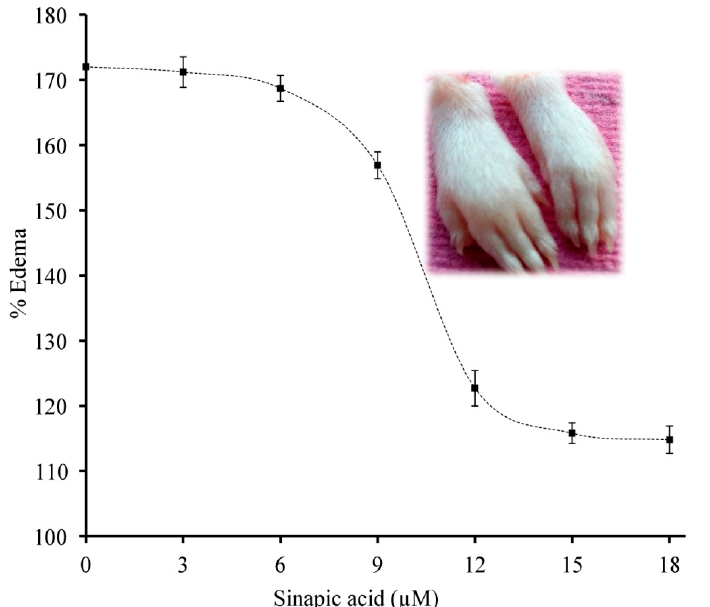
Figure 10. Neutralization of sPLA2-IIA induced edema: The preincubatedsPLA 2 -IIA enzyme (5 µg) with the indicated concentrations of sinapic acid injected to the right hind footpad of mice (20 µL). The mice were euthanized after 45 min and legs were amputated at the ankle, and the edema ratio was calculated. The data are shown in mean ± standard deviation (n = 3).